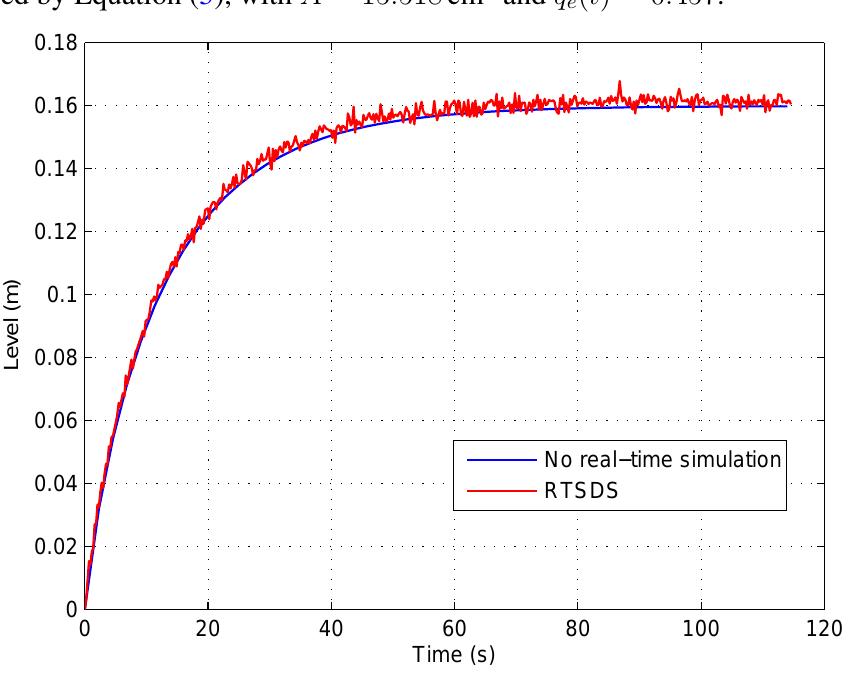
Figure 13. Results obtained for the RTSDS platform applied to the dynamic system characterized by Equation (5), with A = 15 . 518 cm 2 and q